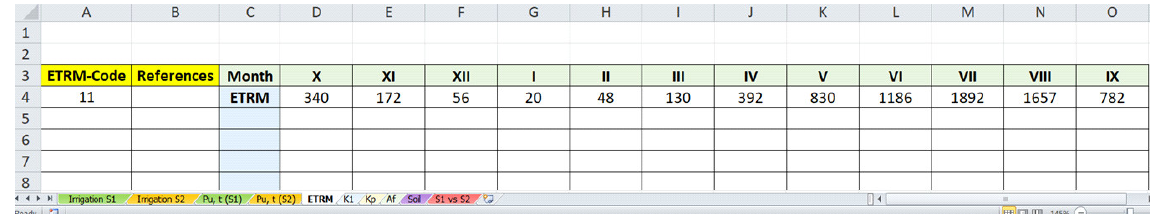
Figure 5. The “Pu, t (S1)” sheet.